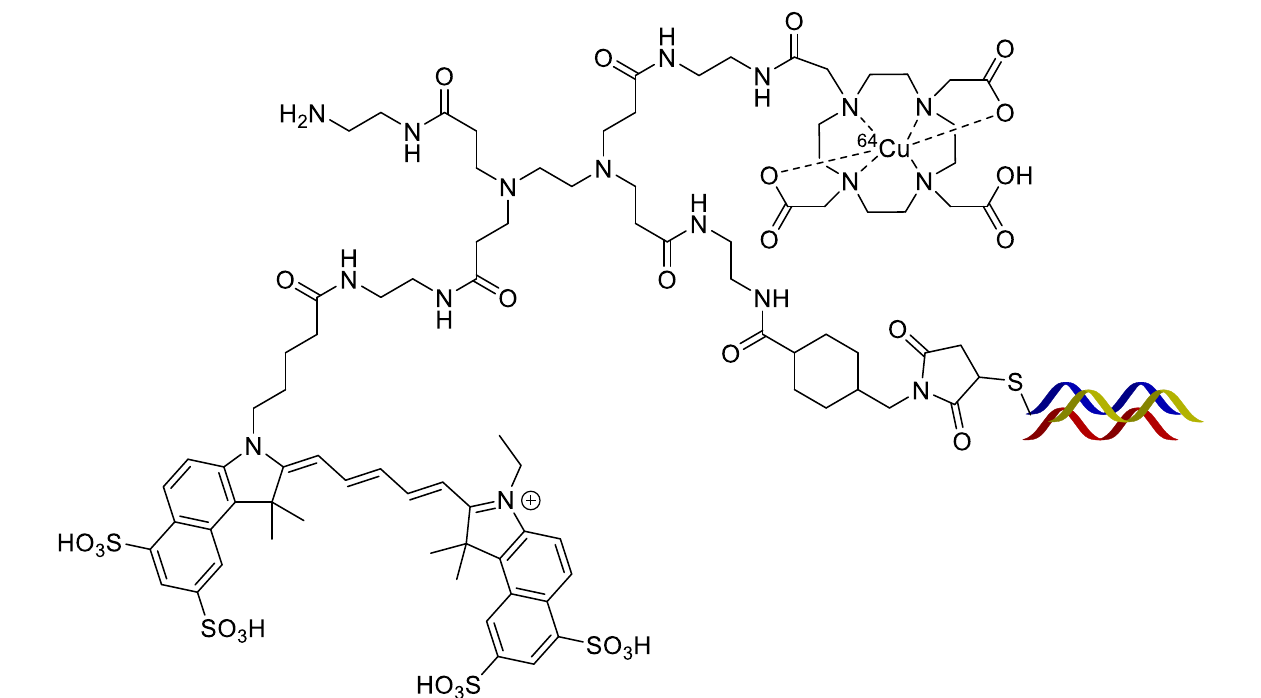
Figure 15. Structure of the Affibody 64 Cu-DPCZ .